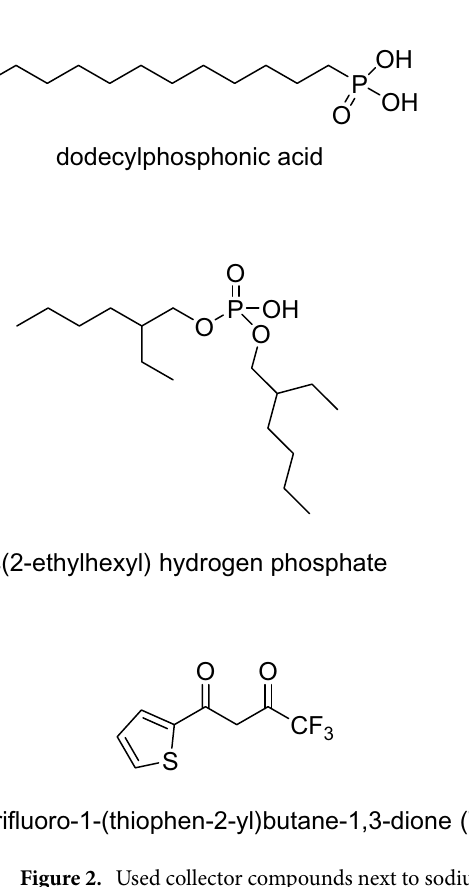
Figure 2. Used collector compounds next to sodium oleate.